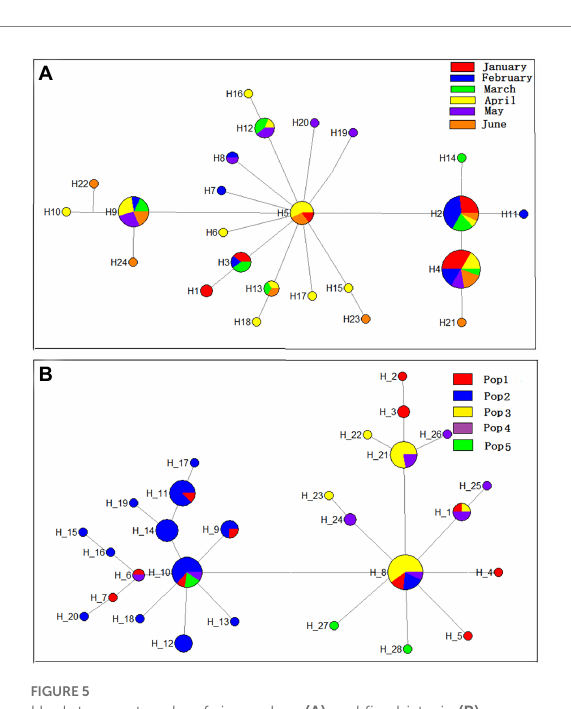
FIGURE 5 Haplotype networks of six modern (A) and five historic (B) groups of D. sinensis in the sediments of Lake Chaohu based on the mitochondrial CO I gene